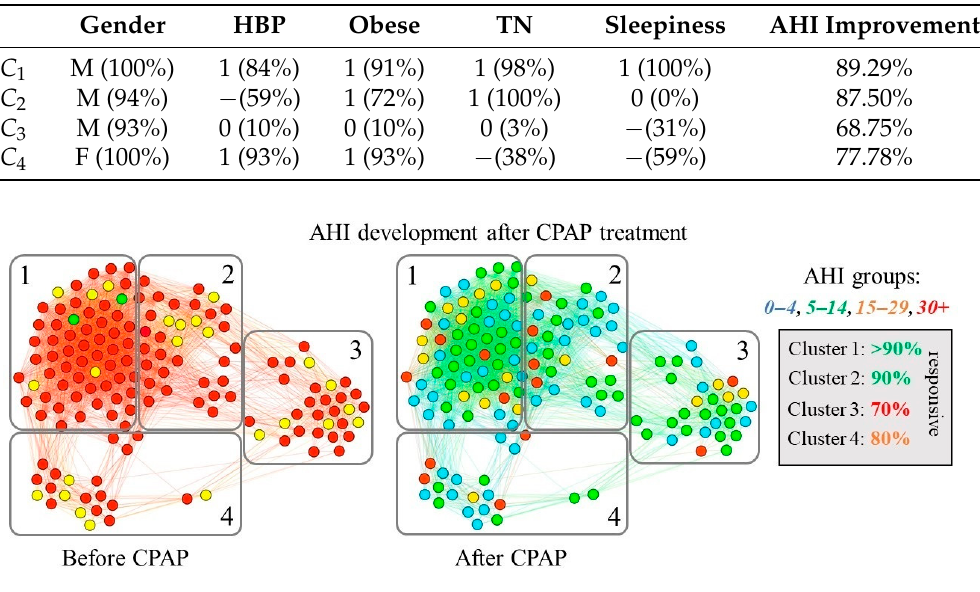
Figure 4. The network of 145 OSA patients highlighting the improvement of AHI in terms of severity class, after the over-night CPAP